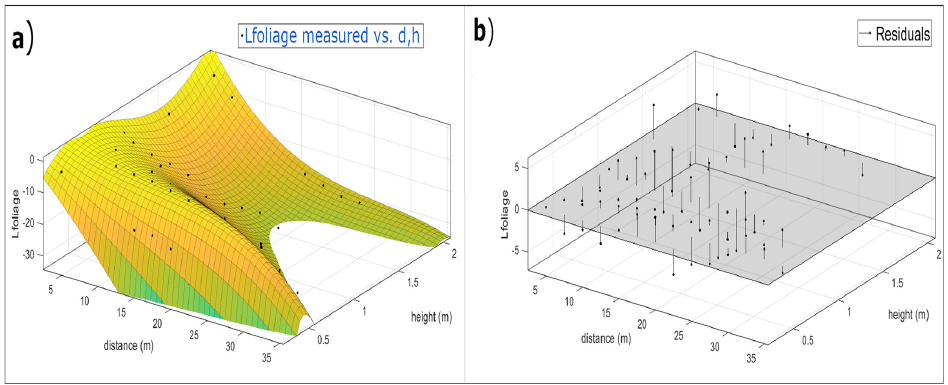
Figure 11. ( a ) Measured values represented by black dots together with the optimized L foliage ( d , h ) model for 15 parameters. ( b ) Residual values of L foliage ( d , h ) determined as di ff erence between measured data and predicted data. Table 4. Parameter values that have been optimized using the cost function of the Equation (3). θ 1 θ